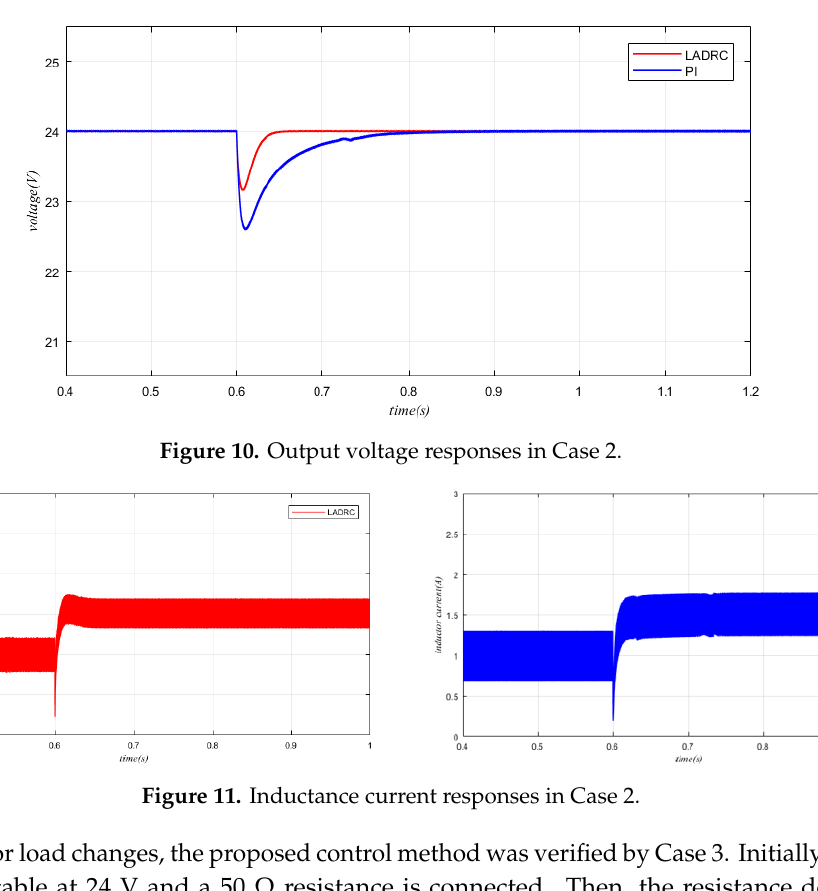
Figure 9. Inductance current responses in Case 1.